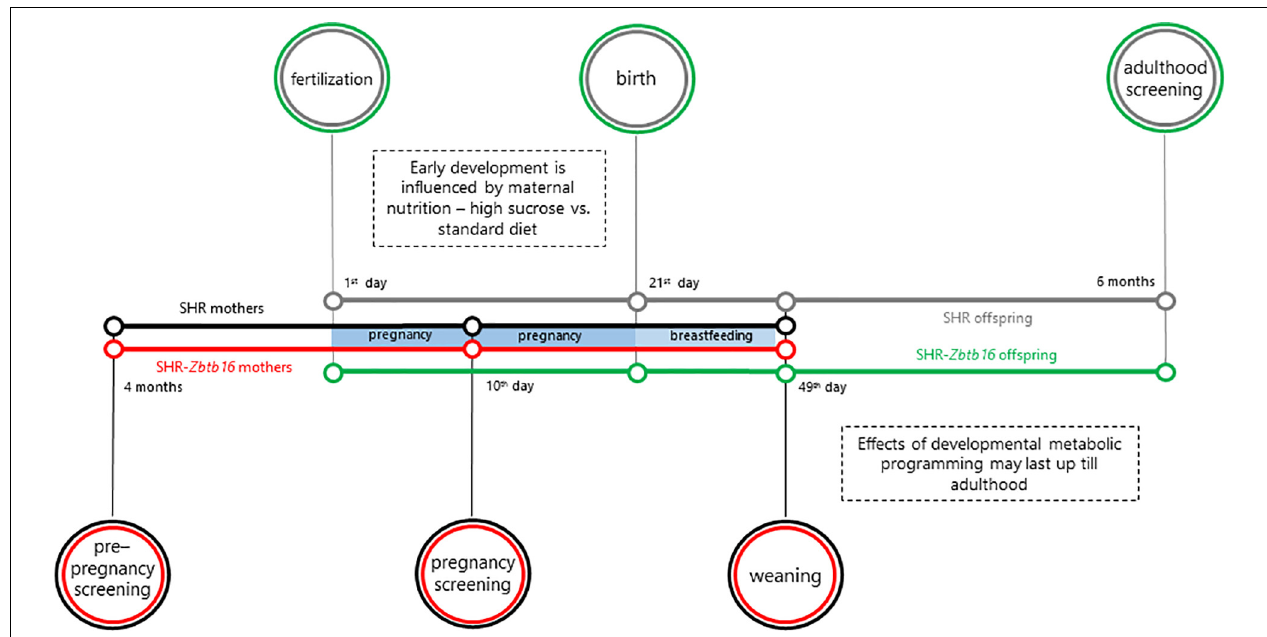
FIGURE 1 | Outline of the study. The colors of the timelines indicate the individual groups: SHR rat dams (mothers, black), SHR- Zbtb16 rat dams (mothers, red), SHR offspring (gray), SHR- Zbtb16 offspring (green).